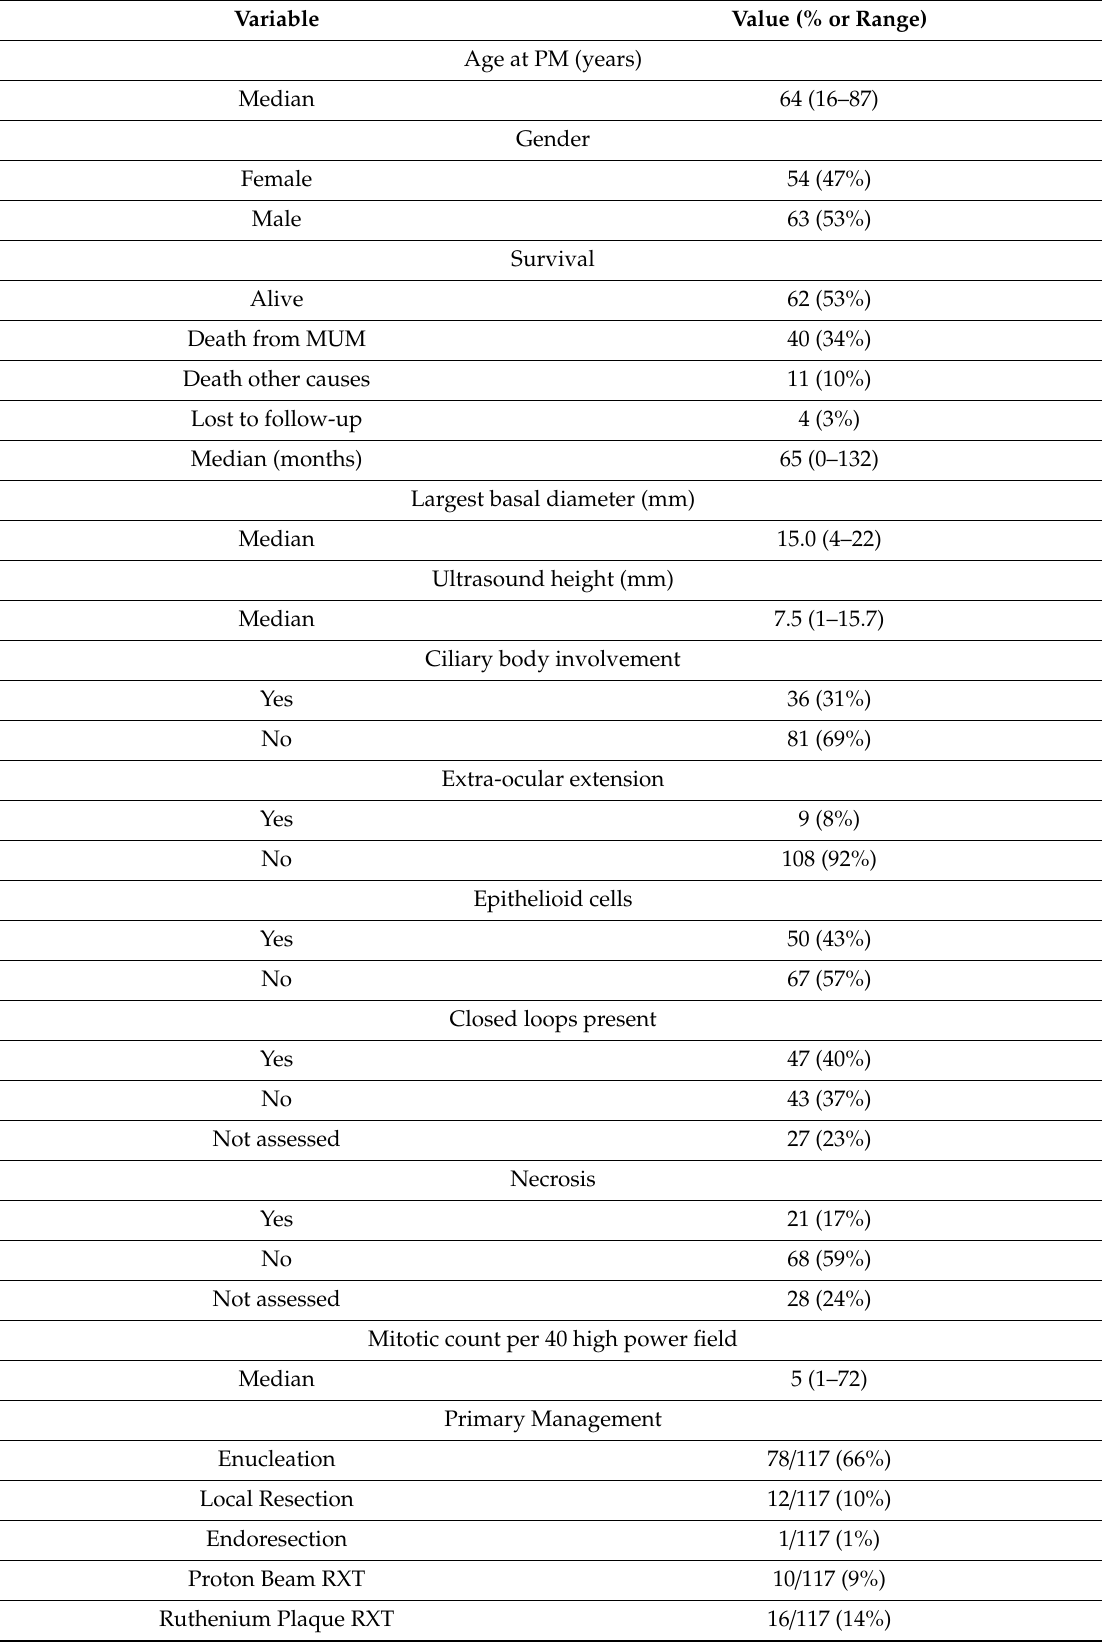
Table 1. Patient and tumor demographics of n = 117 UM patients treated at Liverpool Ocular Oncology